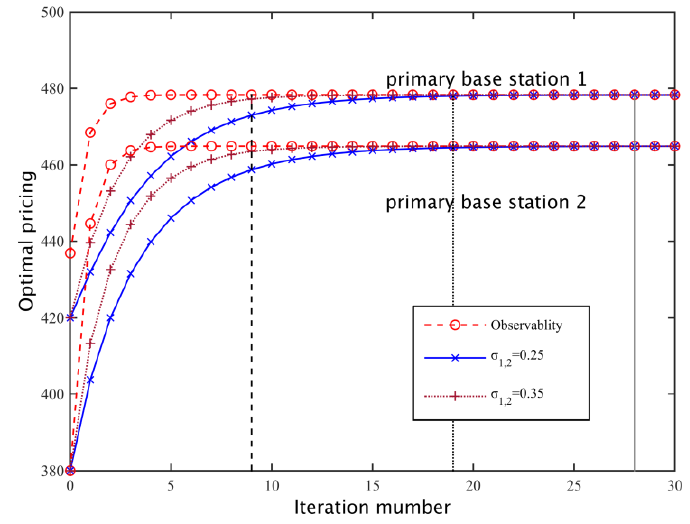
Figure 9. Dynamic game and Nash Equilibrium.